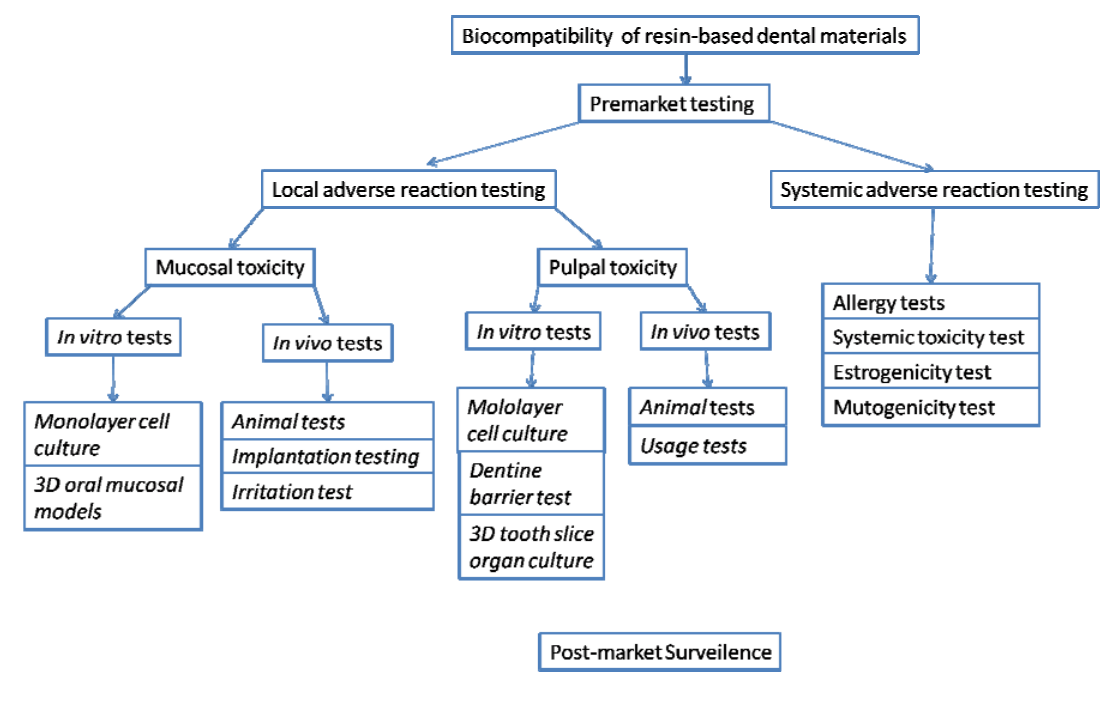
Figure 1 Biocompatibility tests relevant to resin-based dental